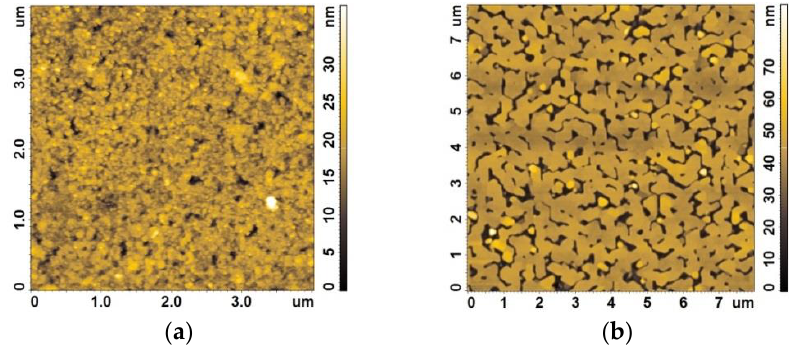
Figure 1. Atomic force microscopy images of Bi 2 Se 3 ( a ) and BSTS ( b ) surfaces.